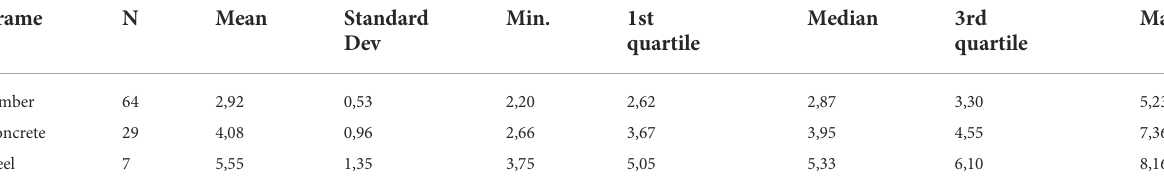
TABLE 3 An overview of GJ/m 2 Embodied Energy of buildings.